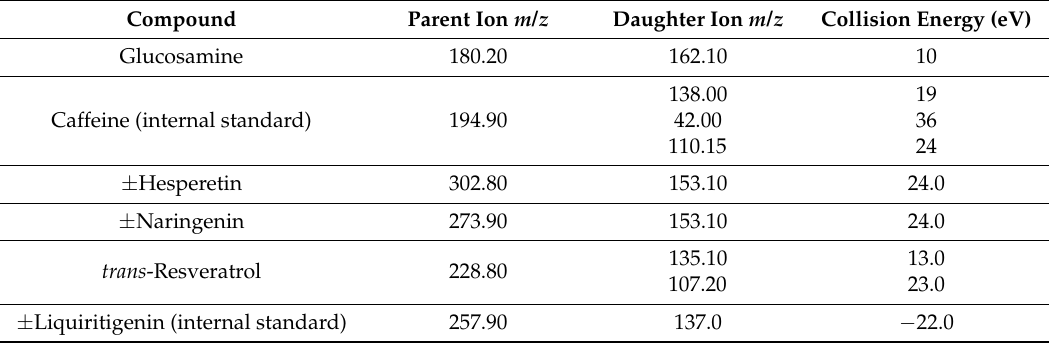
Table 2. Mass spectral multiple reaction monitoring data for glucosamine, ± hesperetin, ± naringenin, trans -resveratrol and the internal standards caffeine and ±